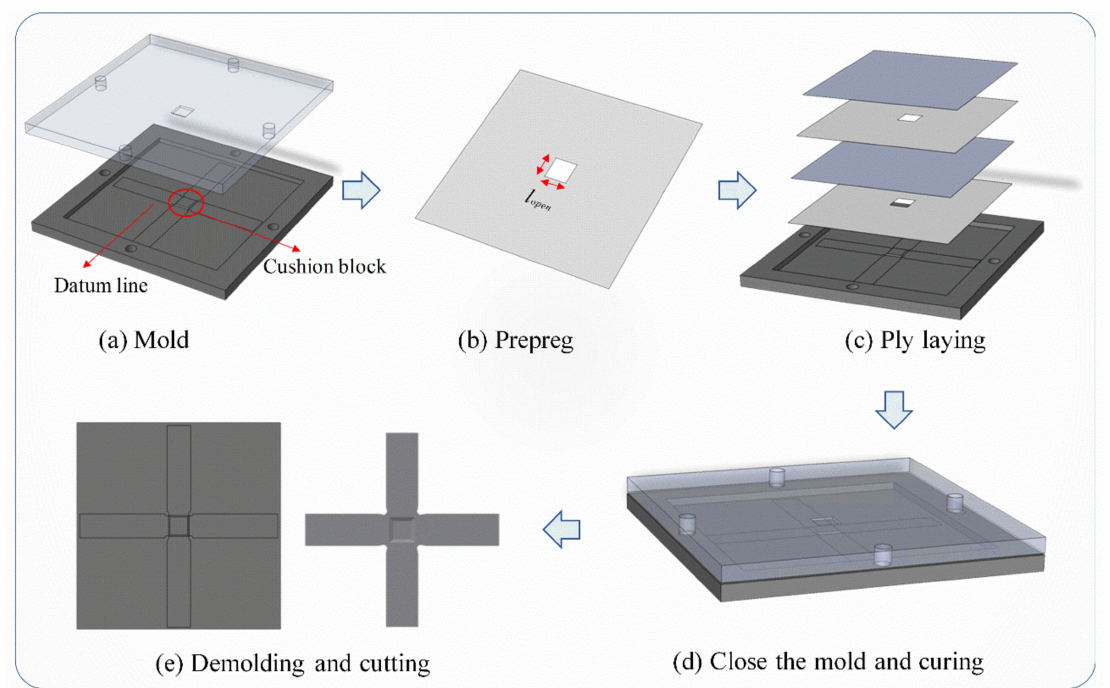
Figure 5. The specific steps are as follows: